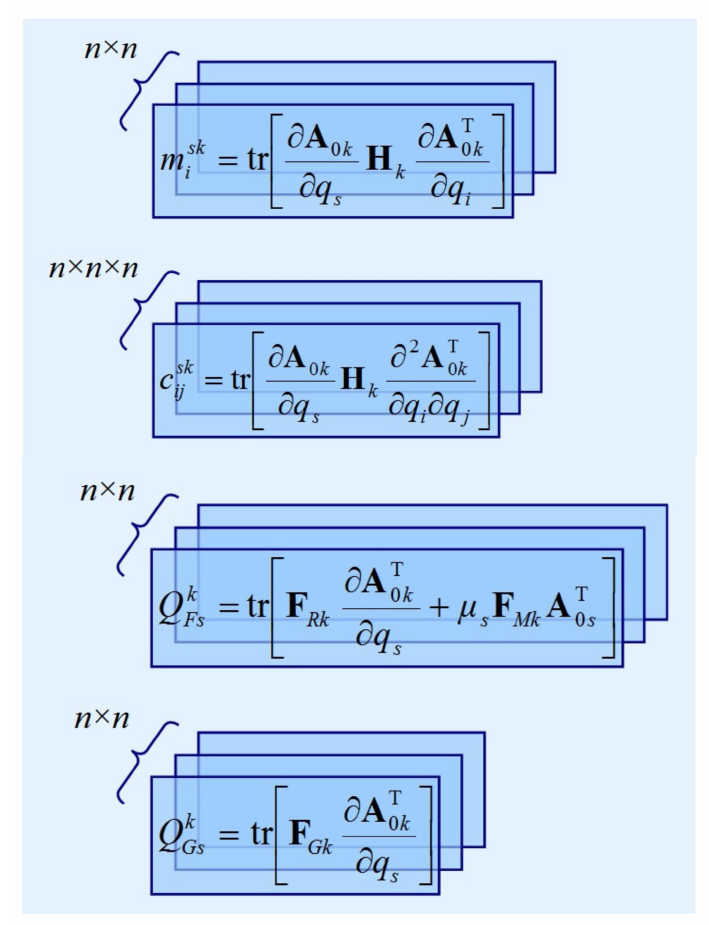
Figure 10. Level III of the algorithm. At the fourth (IV) level, based on objects Ms, Cs, QGs, and QFs, corresponding to the matrices M s and C s (Figure 11), and generalized forces Q Gs and Q Fs (Figure 12), the object schema is being calculated (Figure 7) by the corresponding dynamic model (1).